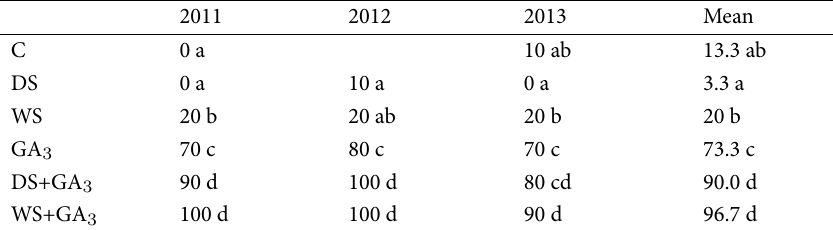
Table 1 Ability of Primula farinosa seeds to germinate (%) in the blotter test after the application of factors breaking dormancy in 2011–2013.